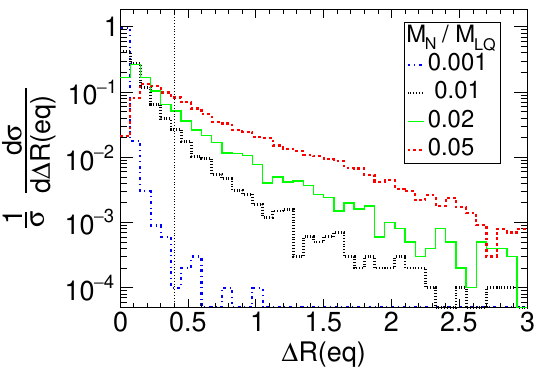
, where the inset figure represents the proper decay width Γ Figure 4 . Distribution of λ lab N The green and red lines indicate contribution of ( W, Z, h ), and LQ states in three-body decay of N with the latter dominating Γ . For W, Z, h mediation, which depend on active-sterile mixing, we N use | V = 0 . 1 eV. 2 ∼ O (10 − 11 − 10 − 12 ) and m eN | ν